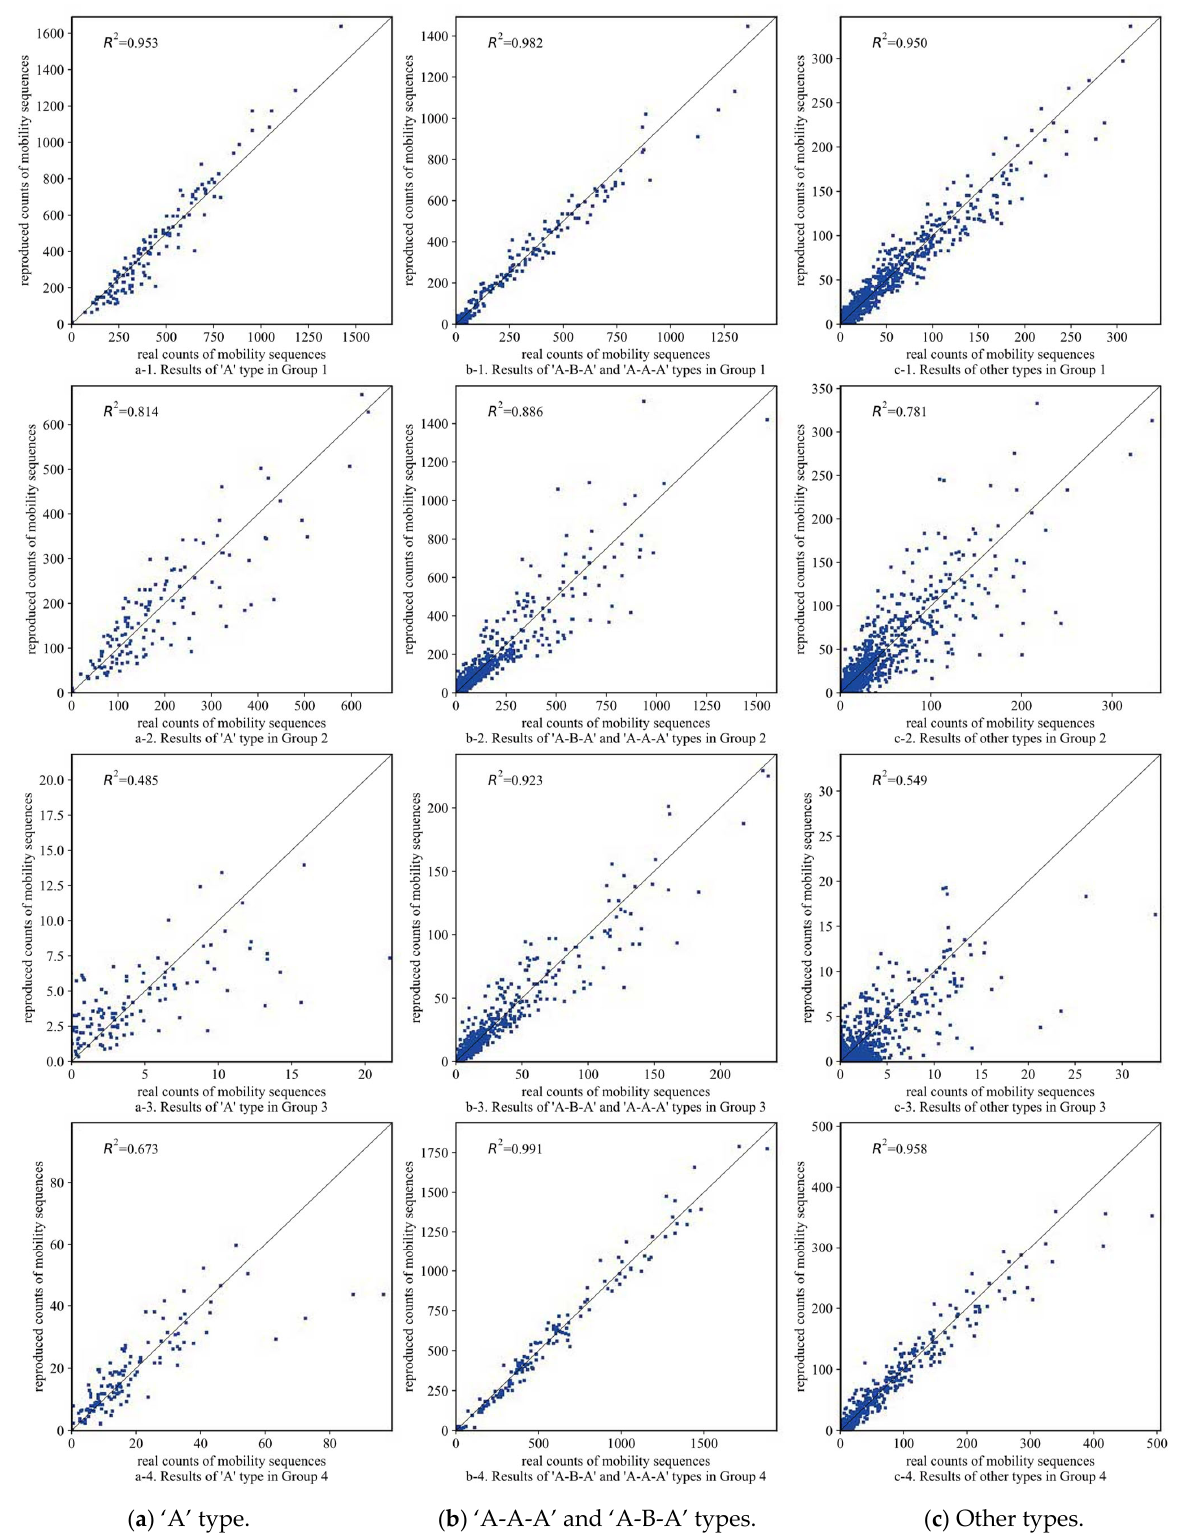
Figure A3. Spatial evaluation for the reproduction results for 1978. ( a ) Results for ‘A’ type; ( b ) Results for ‘A ‐ A ‐ A’ and ‘A ‐ B ‐ A’ types; ( c ) Results for other types.